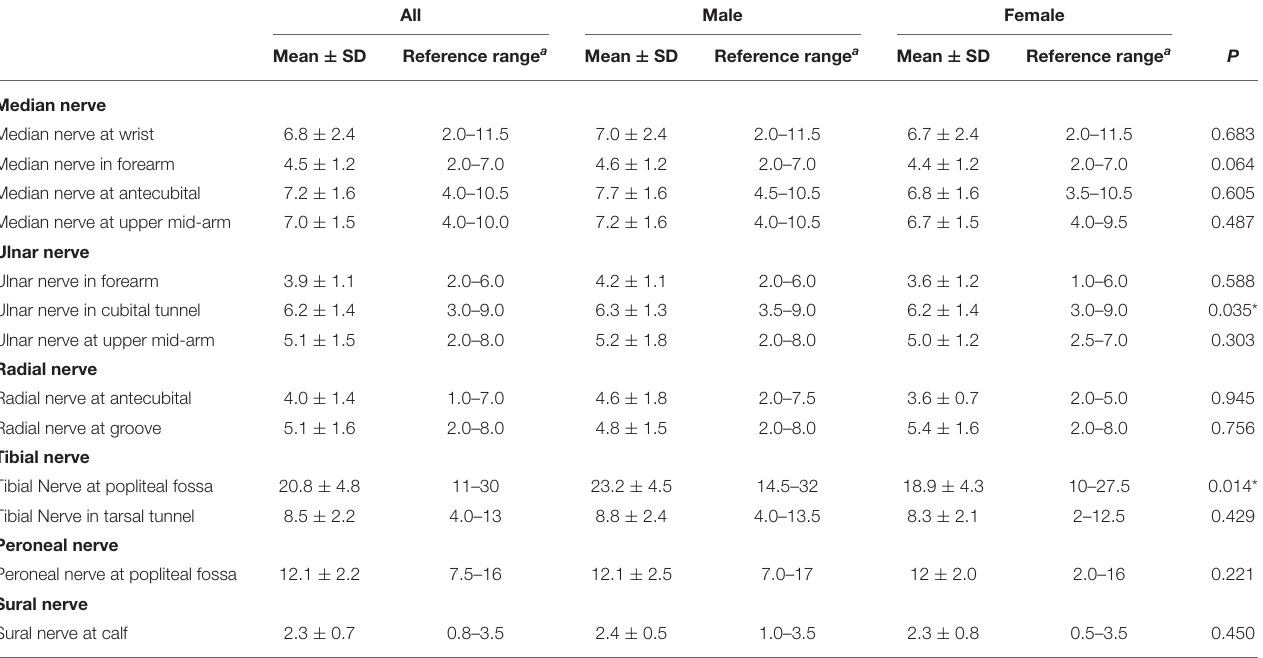
TABLE 2 | Peripheral nerve cross-sectional areas with reference ranges according to